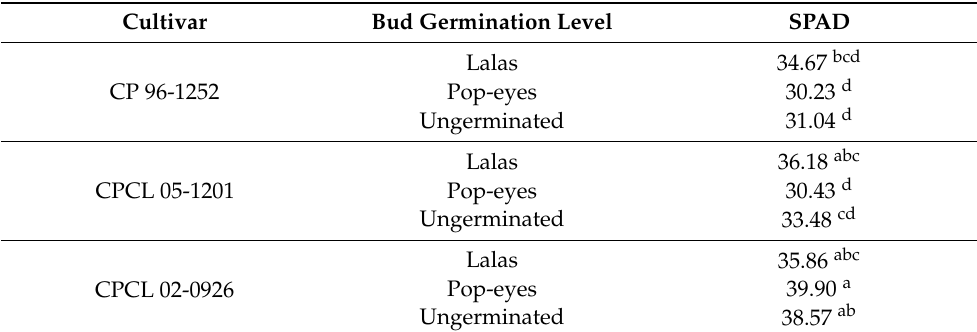
Table 5. ANOVA p -values for SPAD in response to the interaction between cultivar and bud germina- tion level in first greenhouse experiment a